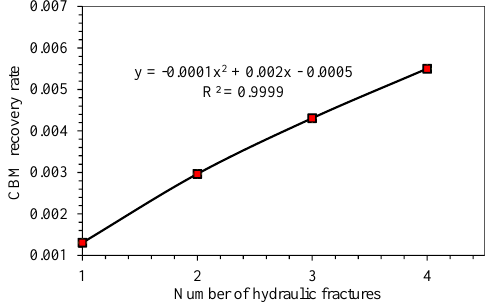
Figure 16. CBM recovery rate with different hydraulic fracture morphologies.